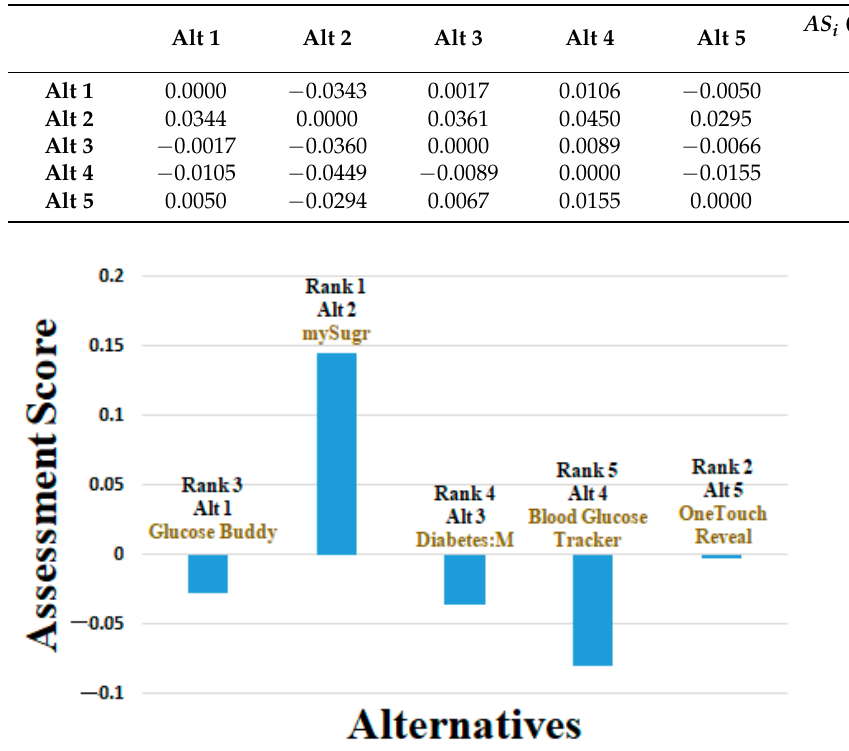
Table 17. Weighted normalized decision matrix, NIS, ED and TD.